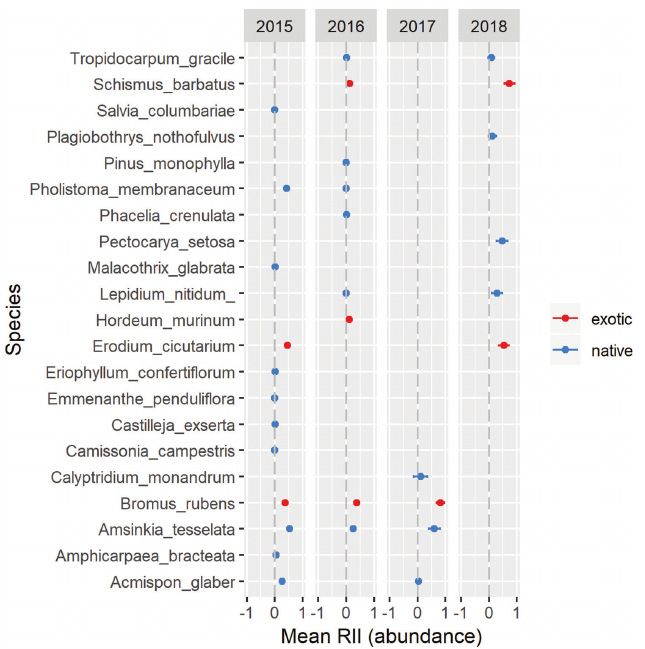
Figure 1. Year-by-year effects (RII ± 95% CI) of native foundation shrubs on the abundance of annual spe- cies. Net effects across all years are summarised in Suppl. material 1: Table A3.